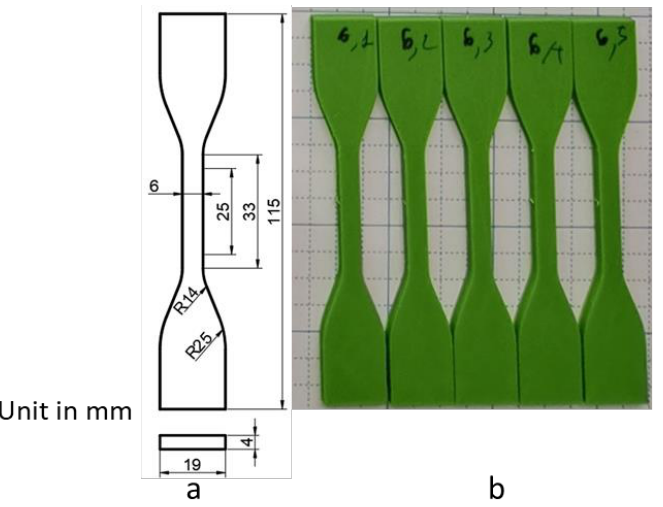
Figure 3. ( a ) Design of the sample for tensile test. ( b ) 3D – printed model using